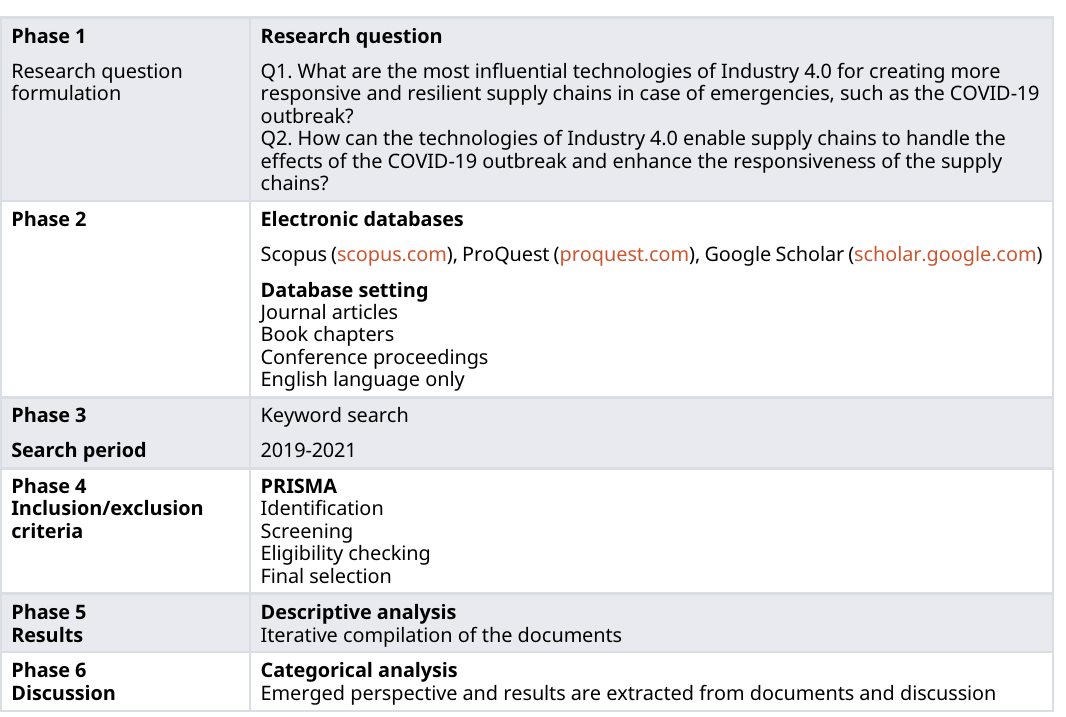
Table 1. Summary of the systematic literature review.